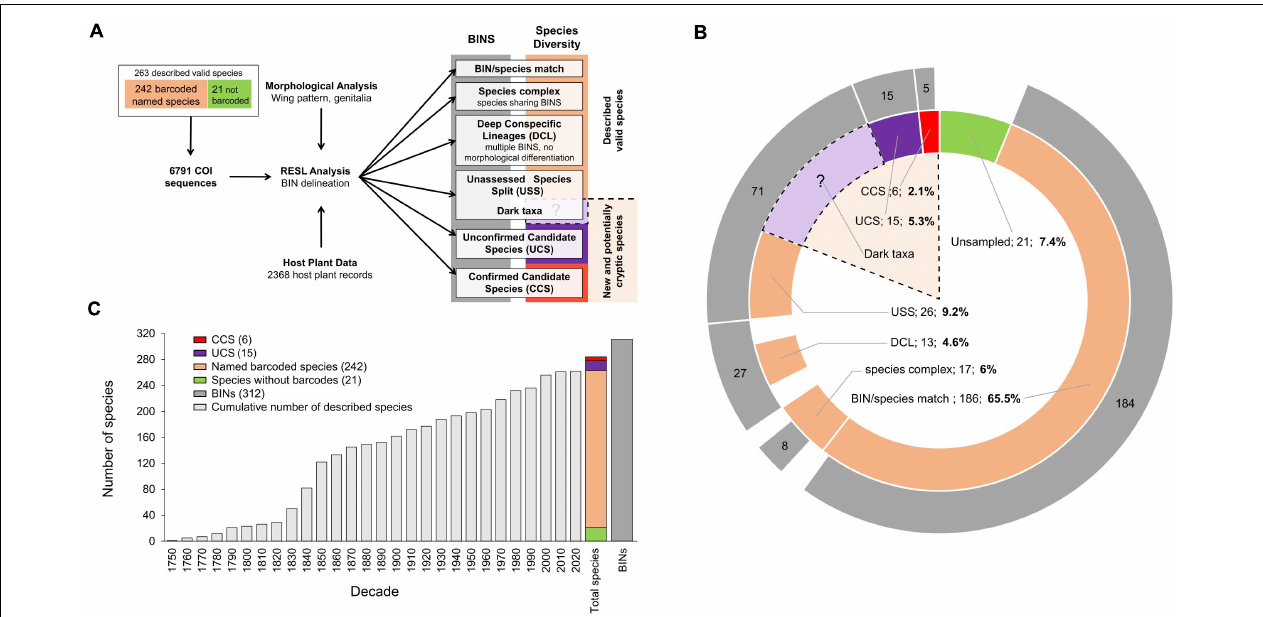
FIGURE 2 | (A) Workflow of integrative taxonomy (candidate species approach) used to identify species boundaries in European Gracillariidae records and to assign them to six species categories with main results. RESL, Refined Single Linkage Analysis implemented in BOLD; BIN, Barcode Index Number. (B) Number of BINs per species category (external circle in gray) and number of species within each category (inner circle): in green, European species lacking DNA barcodes; in beige, the number of named species in each of four species categories; in black, the potential “dark taxa” among 71 BINs representing the 26 USS; in red, the confirmed candidate species (CCS); in purple, the unconfirmed candidate species (UCS). Dotted lines delimit the three species categories comprising new (CCS) and potential cryptic diversity (UCS and USS/dark taxa) in European Gracillariidae. The question mark refers to the unknown number of cryptic species within the 71 BINs of USS category (we refer to those 71 BINs as dark taxa). In the 1:1 species/BIN and the CCS categories, the number of BINs (184) is slightly lower than species numbers (186), because two short DNA barcodes were not automatically assigned BIN numbers on BOLD; they nonetheless represent monophyletic genetic units and were considered within these categories. Percentages are given for each category with respect to a total number of species of 284 (including CCS and UCS), ignoring the unknown part represented by splits in unaddressed species (USS). (C) For the 263 named valid species recognized in 2020, this histogram represents the cumulative number of species described per decade since 1750. It also shows the 312 BINs and the increase from 263 described species (in green, 21 without DNA barcodes; in beige, 242 with DNA barcodes) to 284 species including 6 CCS (red) and 15 UCS